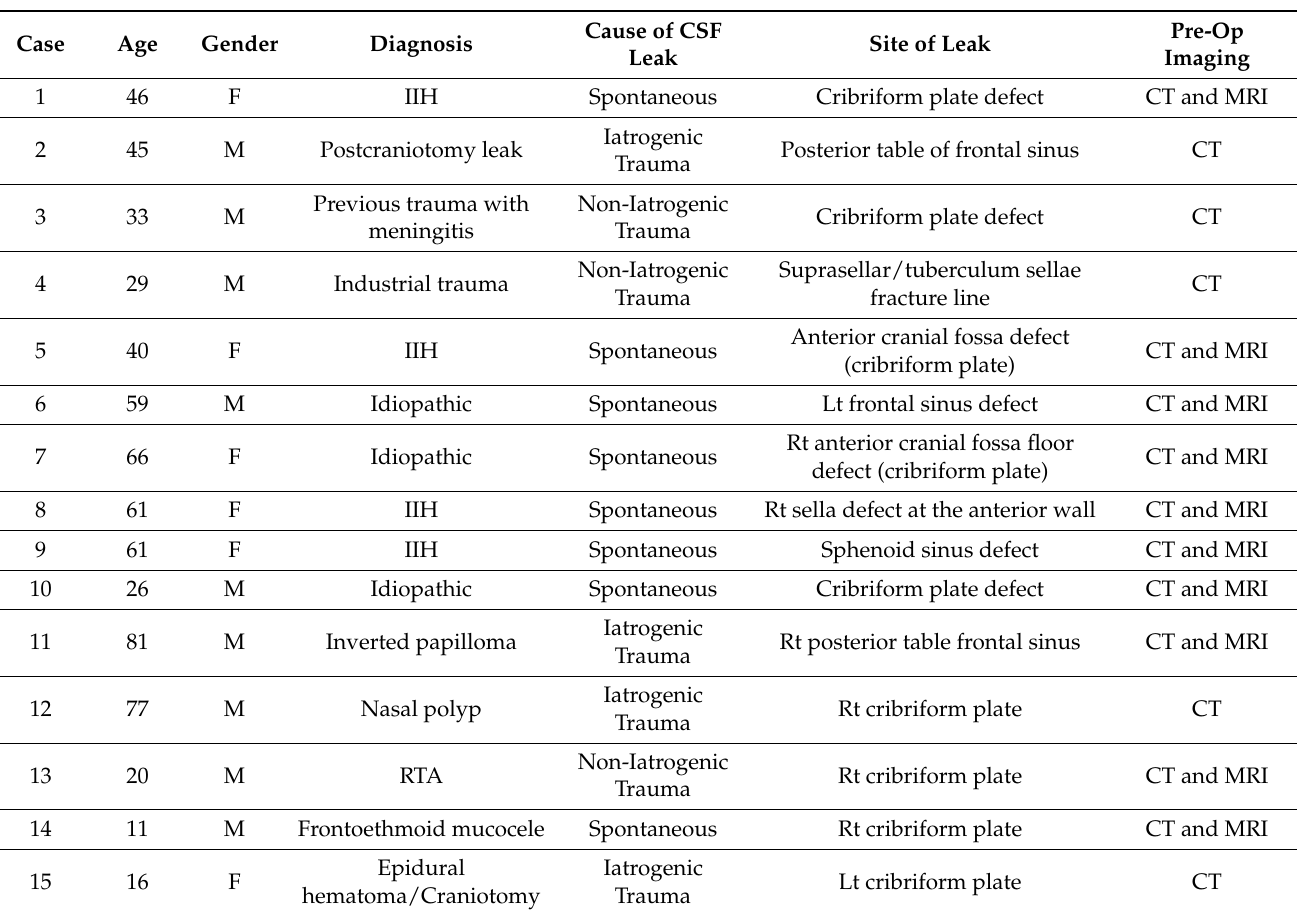
Table 1. Patient demographics (F: Female, M: Male, IIH: Idiopathic Intracranial Hypertension, Rt: Right, Lt: